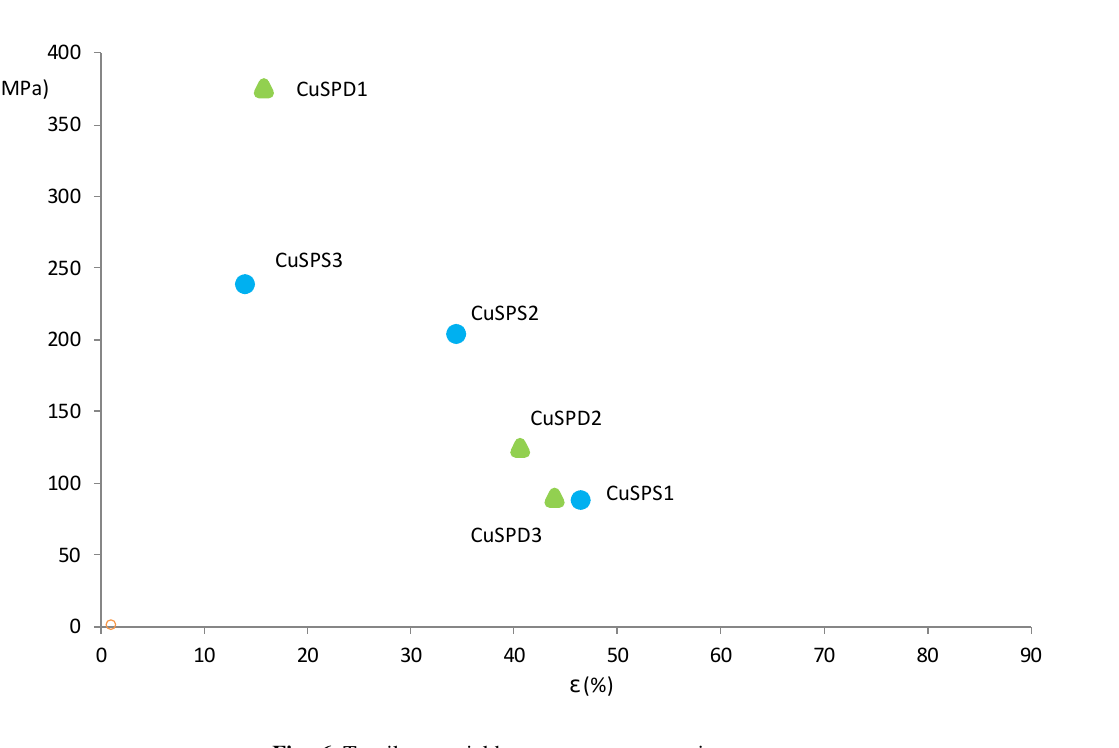
Fig. 6. Tensile true yield stress versus true strain.